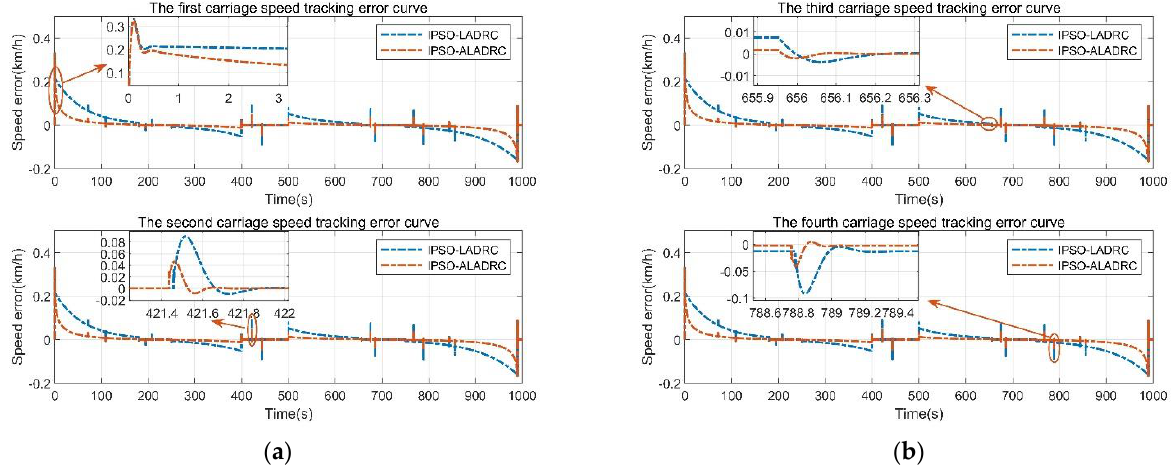
Figure 9. Speed tracking error of the four carriages: ( a ) Speed tracking error of the first two carriages; ( b ) Speed tracking error of the last two carriages.